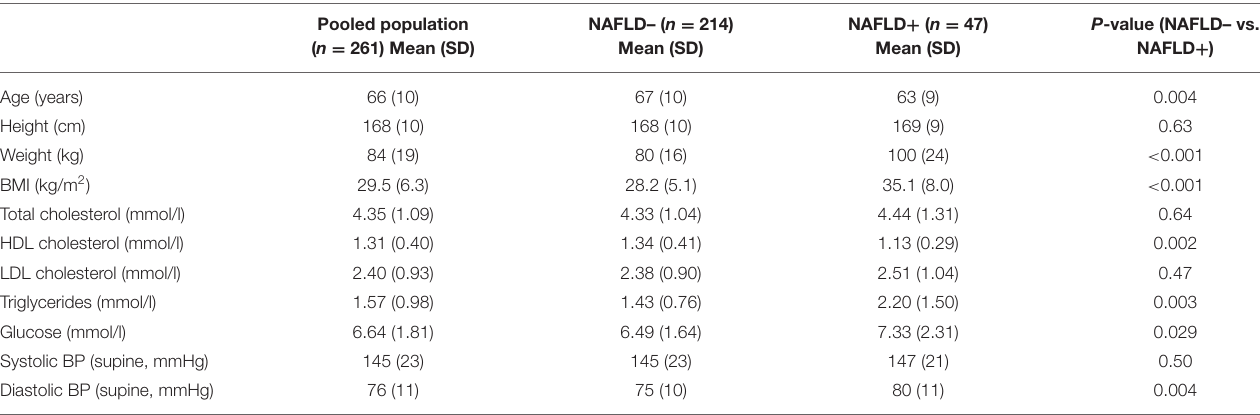
TABLE 1 | Clinical characteristics of the study